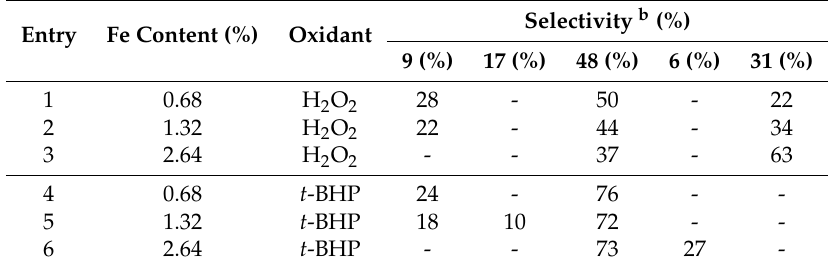
Table 19. FeEuroPh-catalyzed allylic oxidation of limonene 2 : H 2 O 2 vs. t -BHP a (adapted from reference